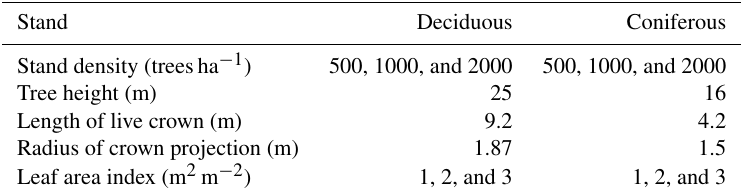
Table 2. Stand parameters for the four-scale model.